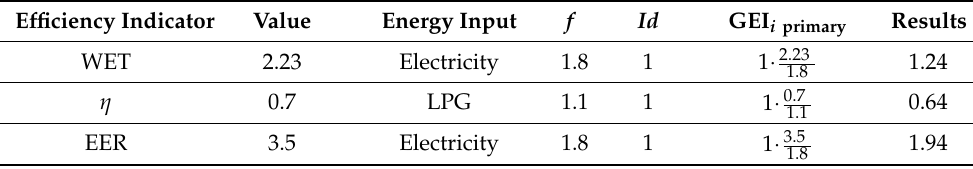
Table 4. GEI s calculation for the second configuration.